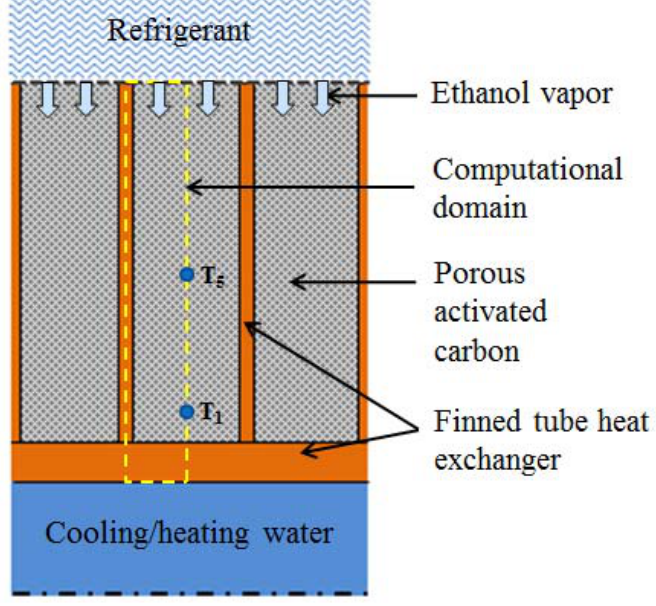
Figure 2. 2D-axisymmetric geometry of the finned tube adsorber showing computational Figure 2. 2D ‐ axisymmetric geometry of the finned tube adsorber showing computational domain.